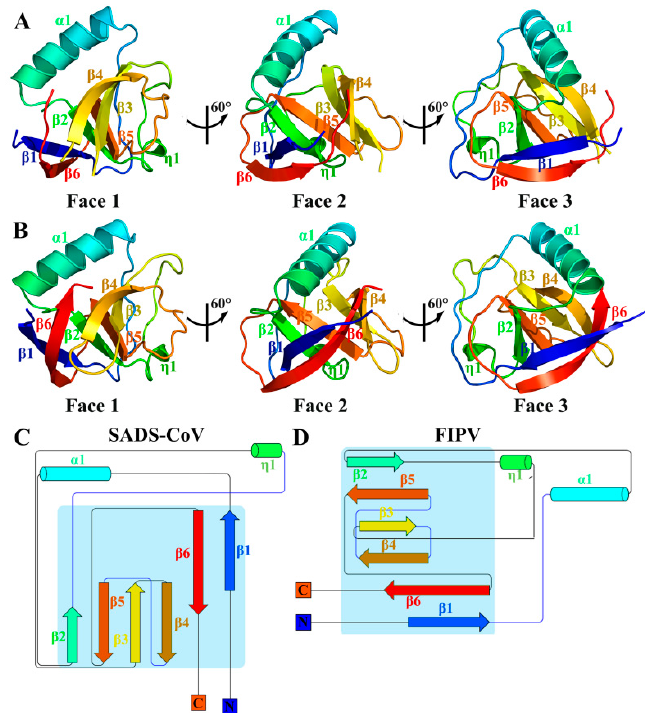
Figure 1. Overall architecture of swine acute diarrhea syndrome coronavirus (SADS-CoV) and feline infectious peritonitis virus (FIPV) non-structural protein 1 (nsp1). ( A , B ) Faces 1 to 3 of the SADS-CoV and FIPV nsp1 structures are illustrated in rainbow colors from the N terminus (blue) to the C-terminus (red). ( C , D ) Topology diagram of SADS-CoV and FIPV nsp1, with secondary structural elements sequentially numbered and colored from N to C as described for panels A and B. α -helices are indicated by cylinders, and β -strands are indicated by arrows. Panels A and B were produced using PyMOL (Delano Scientific), and the topology diagram was produced using